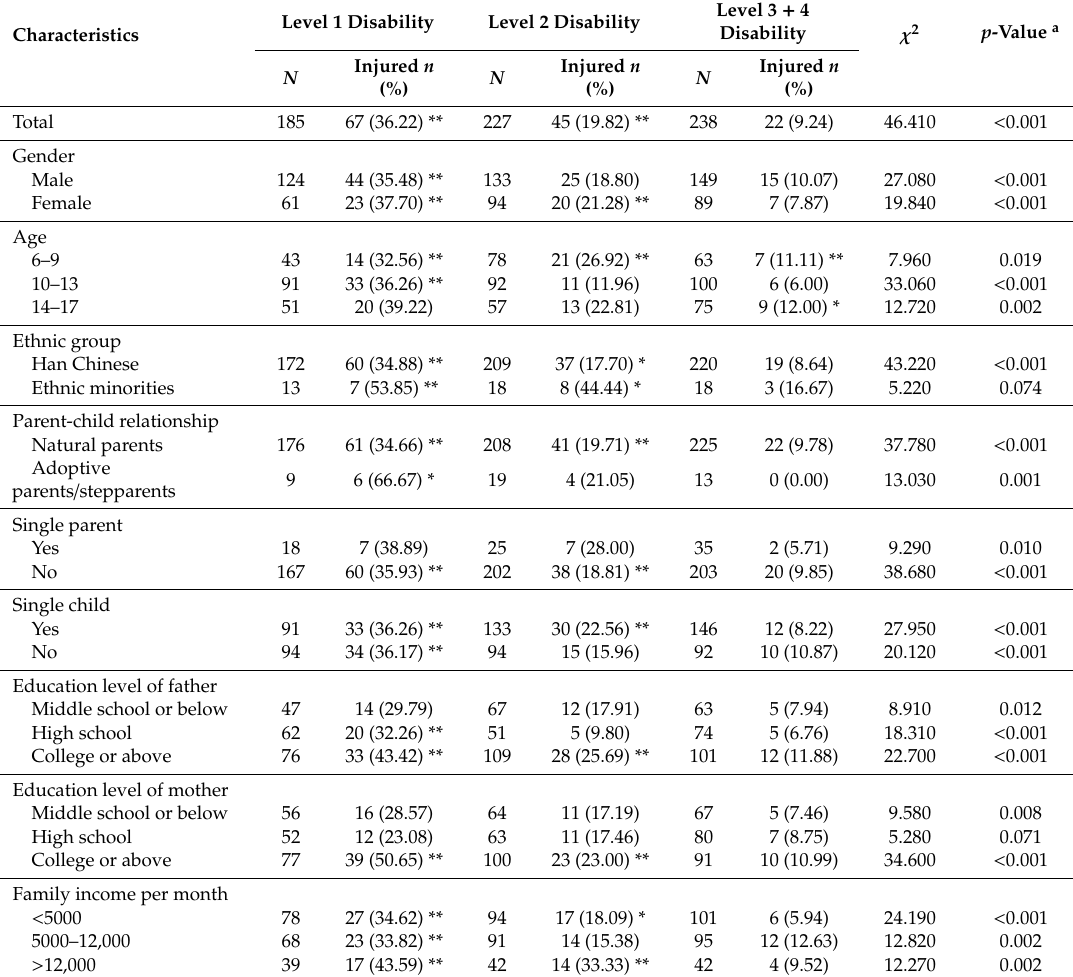
Table2. RatesofDSHamongchildrenwithdi ff erentseverityofdisabilitiesbyselectedsociodemographic factors in Beijing,